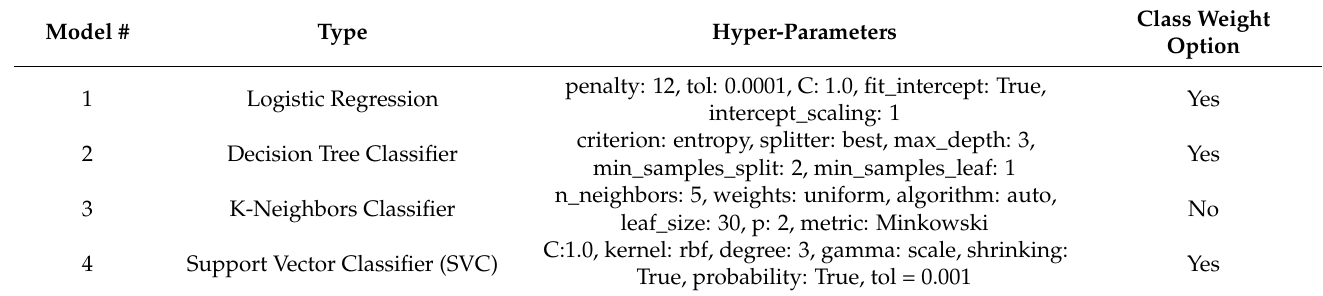
Table 5. Classification Models